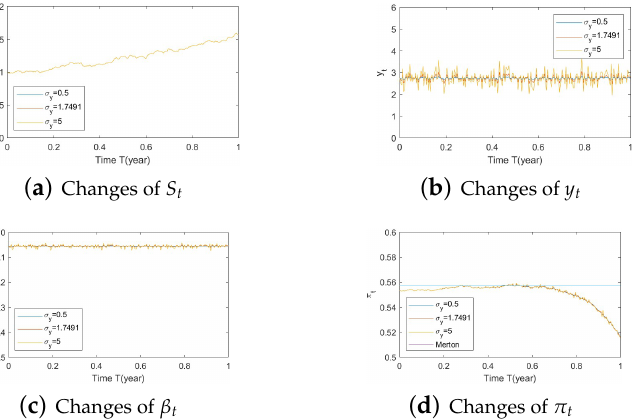
Figure A11. Illustrate the impact on ( a ) stock prices, ( b ) driver of elasticity, ( c ) elasticity of volatility, and ( d ) optimal stock allocations when varying θ y ( e . g ., θ y = − 5,2.7505,15 ) .